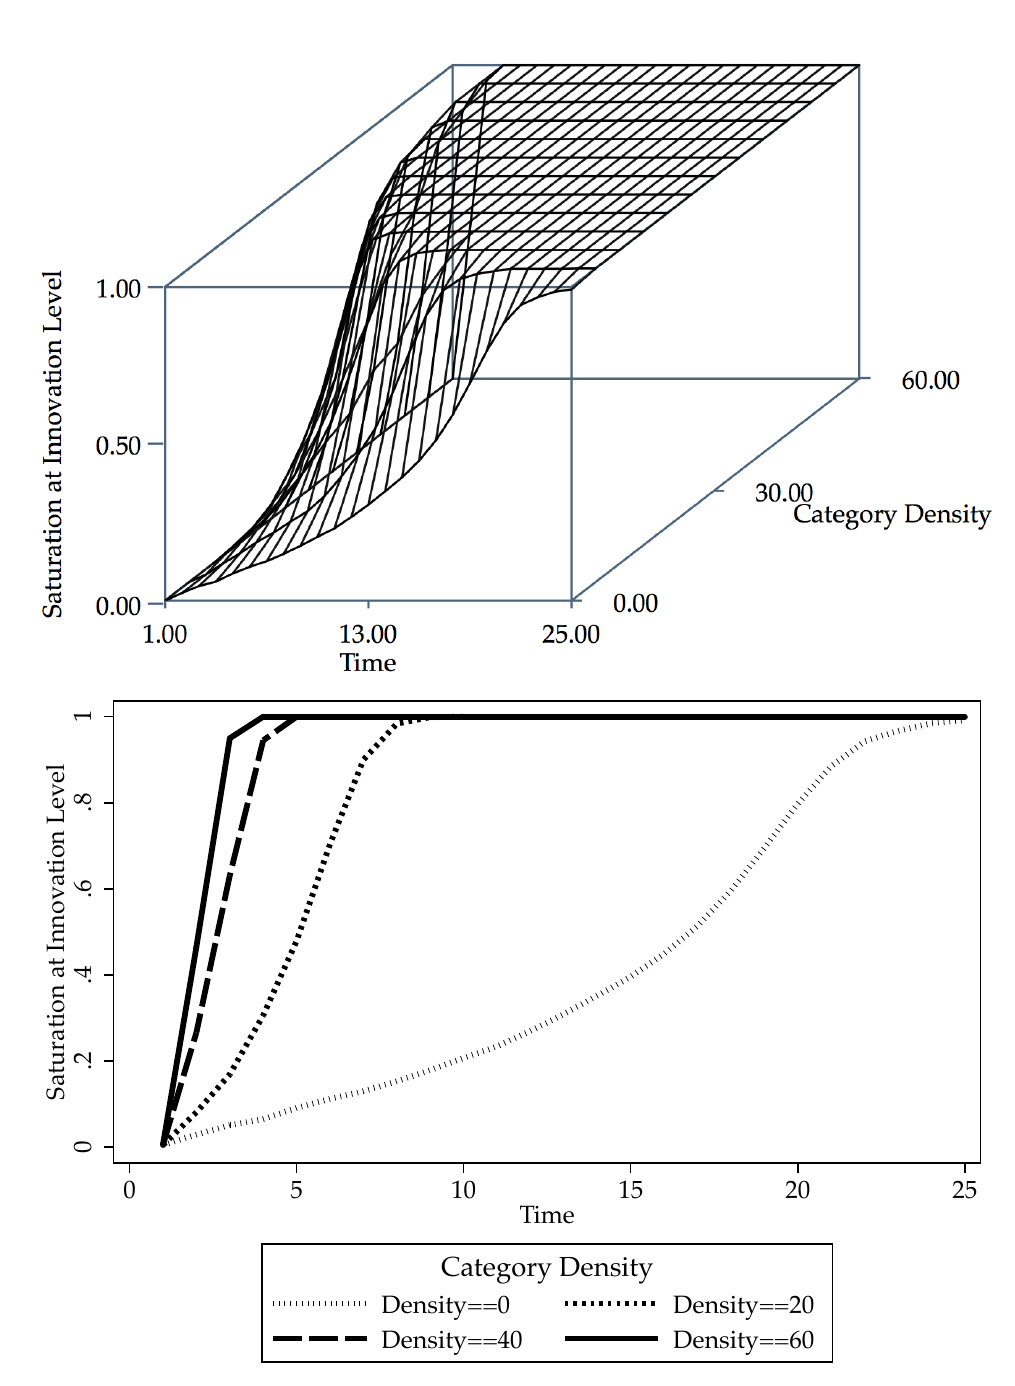
Figure 2: Simulated innovation diffusion by category density.